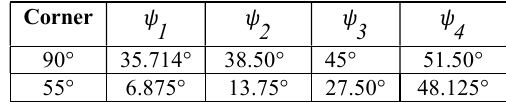
Figure 6. Details of the site location of 90° corner On the wall surfaces, checker boards of 37mm size (5×8 grids) are applied for validation of overlap fraction by image matching algorithms, which is an image-based method. For each case of two corners, camera positions are decided in field such that both sides of the wall facades are visible in each image. Four camera positions ( ψ ) are marked on the circular path from left end of the circular path. Table 1 shows, the camera positions for the two sites.